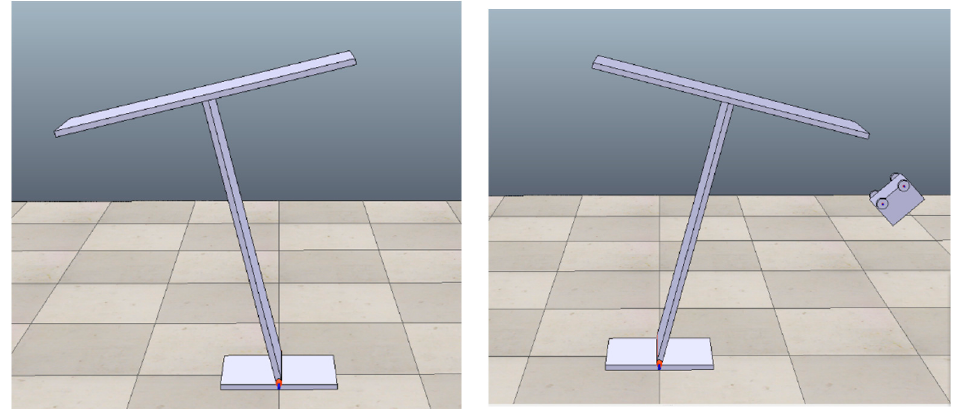
Figure 8. End of simulation of one episode when the table tilt angle is too large.